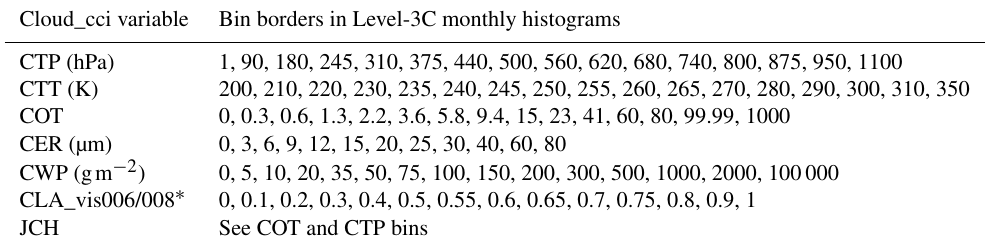
Table 5. Bin borders of Cloud_cci Level-3C histograms of cloud-top pressure (CTP), cloud-top temperature (CTT), cloud optical thickness (COT), cloud effective radius (CER), liquid and ice water path (CWP), cloud albedo (CLA), and joint cloud property histogram